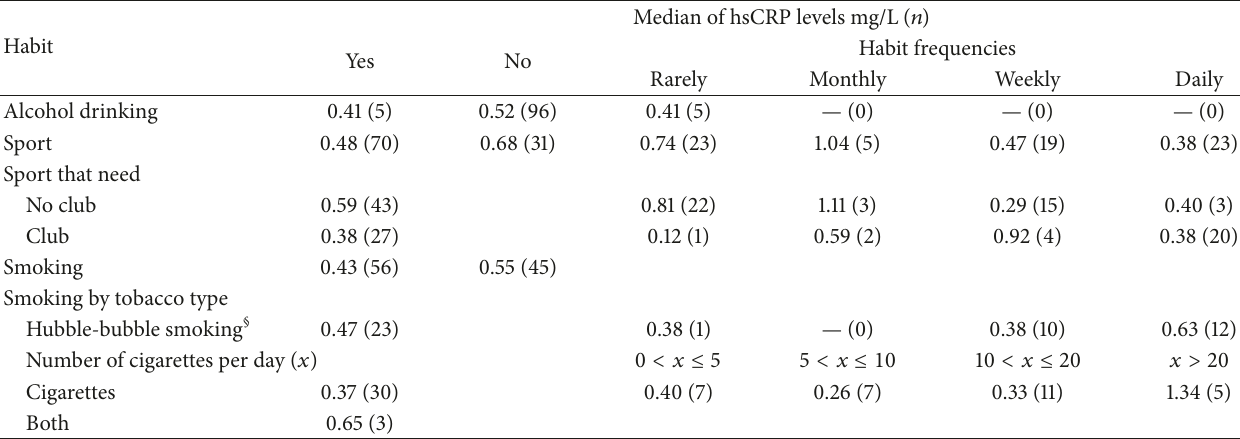
Table 4: Participants grouped by alcohol drinking, smoking, or sport habits characteristics. Median of hsCRP levels (mg/L) and participants numbers (𝑛) of each group were shown (𝑛 = 101) . Damascus, Syria, April 2016.